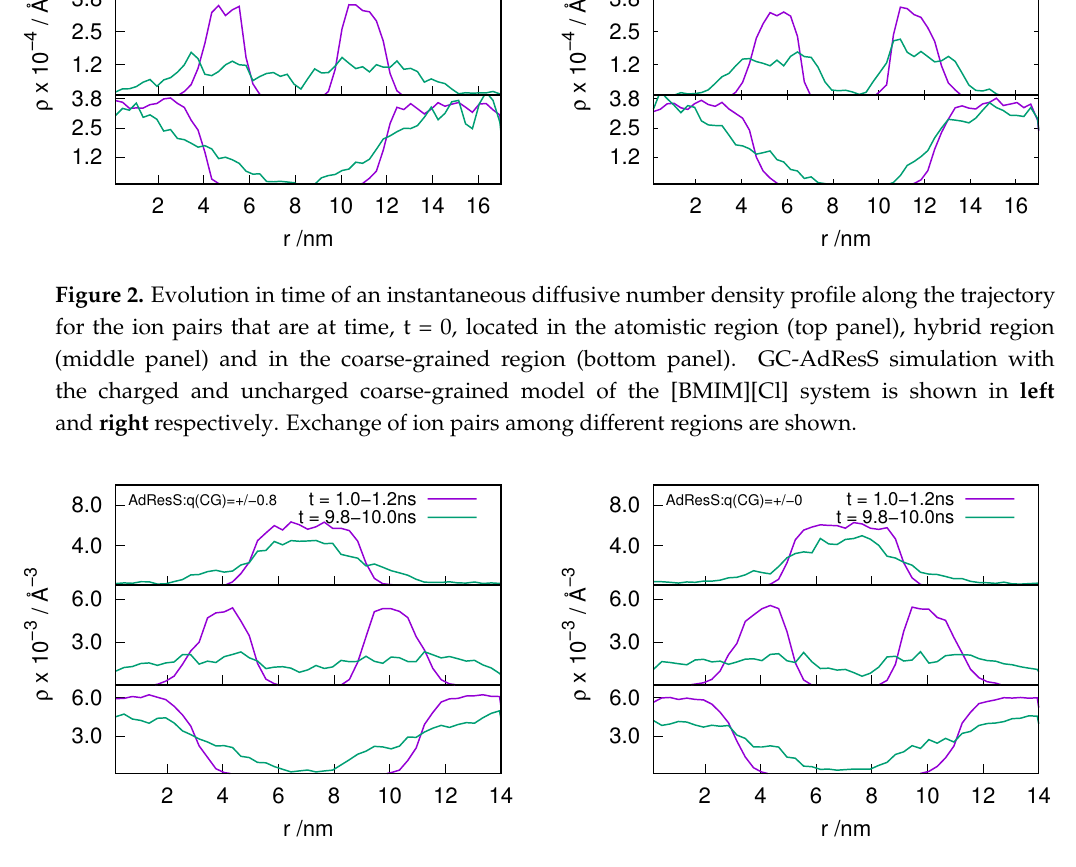
Figure 3. Evolution in time of an instantaneous number diffusive density profile along the trajectory for the ion pairs that are at time, t = 0, located in the atomistic region (top panel), hybrid region (middle panel) and in the coarse-grained region (bottom panel). GC-AdResS simulation with the charged and uncharged coarse-grained model of the [ BMIM ][ BF 4 ] system is shown in left and right respectively. Exchange of ion pairs among different regions are